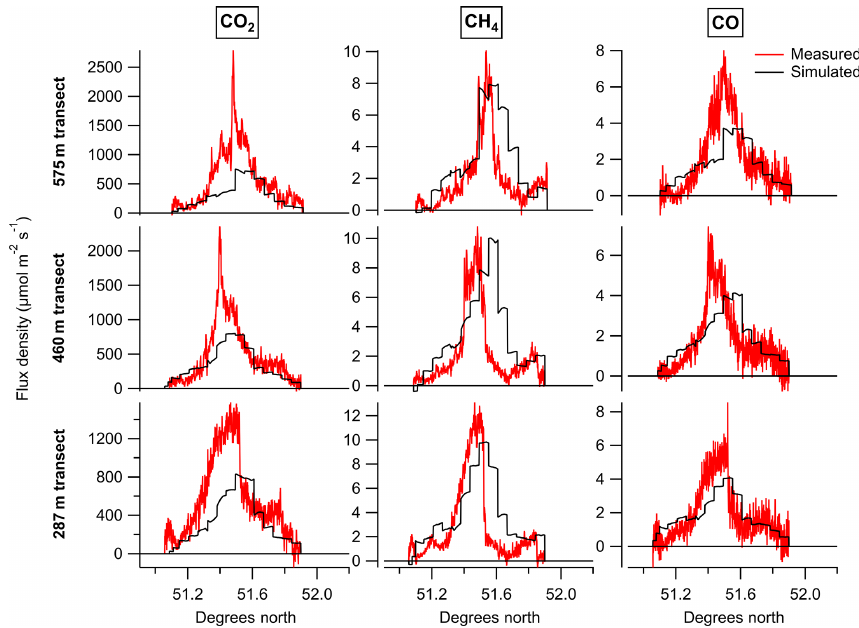
Figure 6. Measured and simulated flux densities for CO 2 , CH 4 and CO, given for the three transects (287, 460 and 575m) used to assess inventory